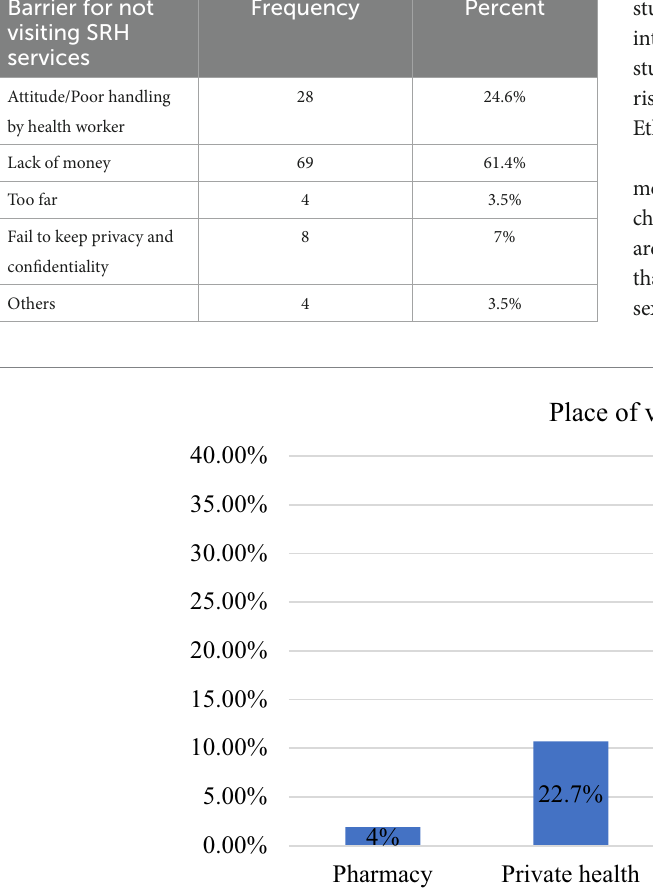
TABLE 2 Common barriers of street children’s for not visiting health institutions for SRH services in Wonago town, September 2021 ( N = 113). Barrier for not visiting SRH